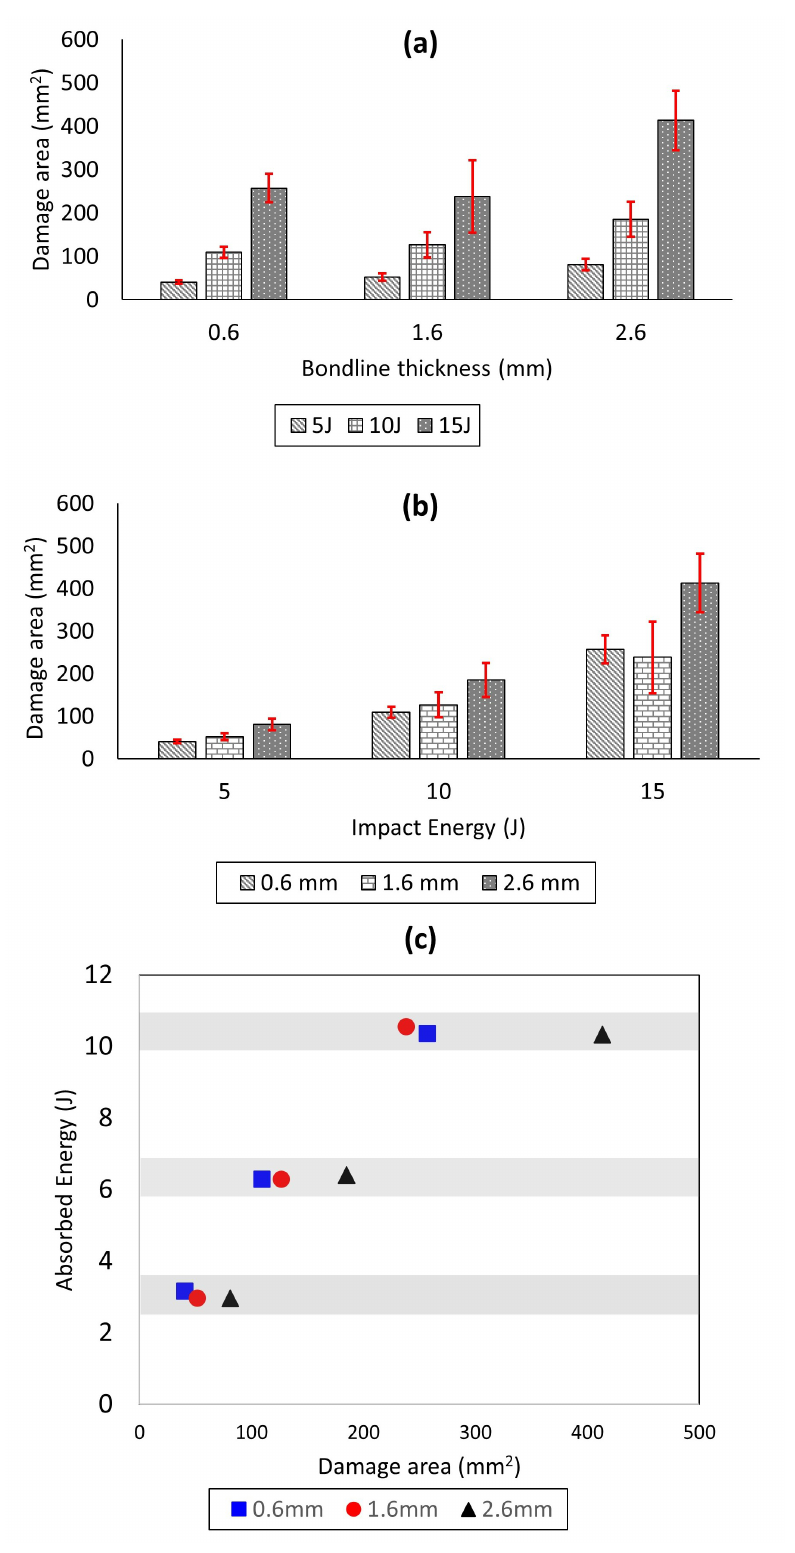
Figure 20. Comparison of impact-induced projected damage area in joints for different ( a ) bondline thicknesses, ( b ) impact energies, and ( c ) absorbed